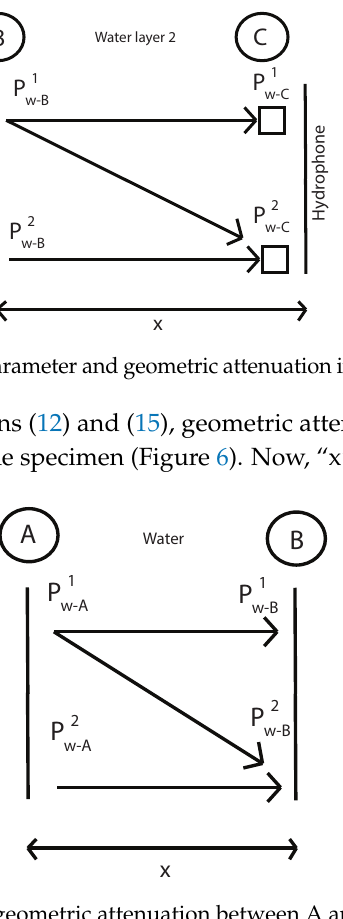
Figure 6. Determination of the geometric attenuation between A and B points without